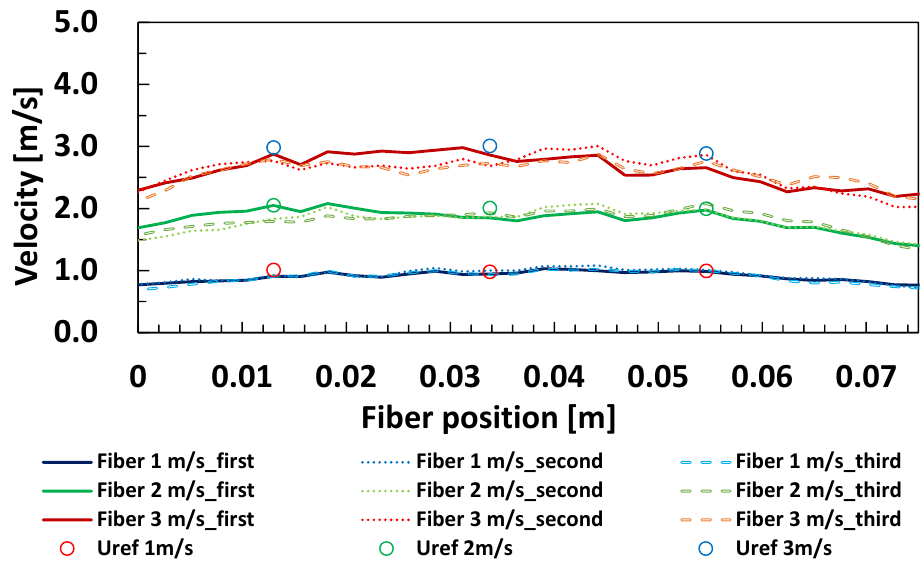
Figure 9. Effect of wind velocity on velocity distribution along the optical fiber.